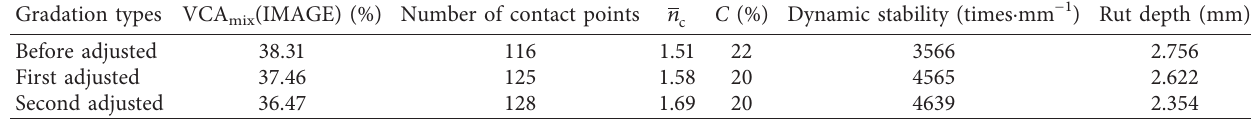
Table 9: Meso parameters and rutting test results before and after gradation optimisation.